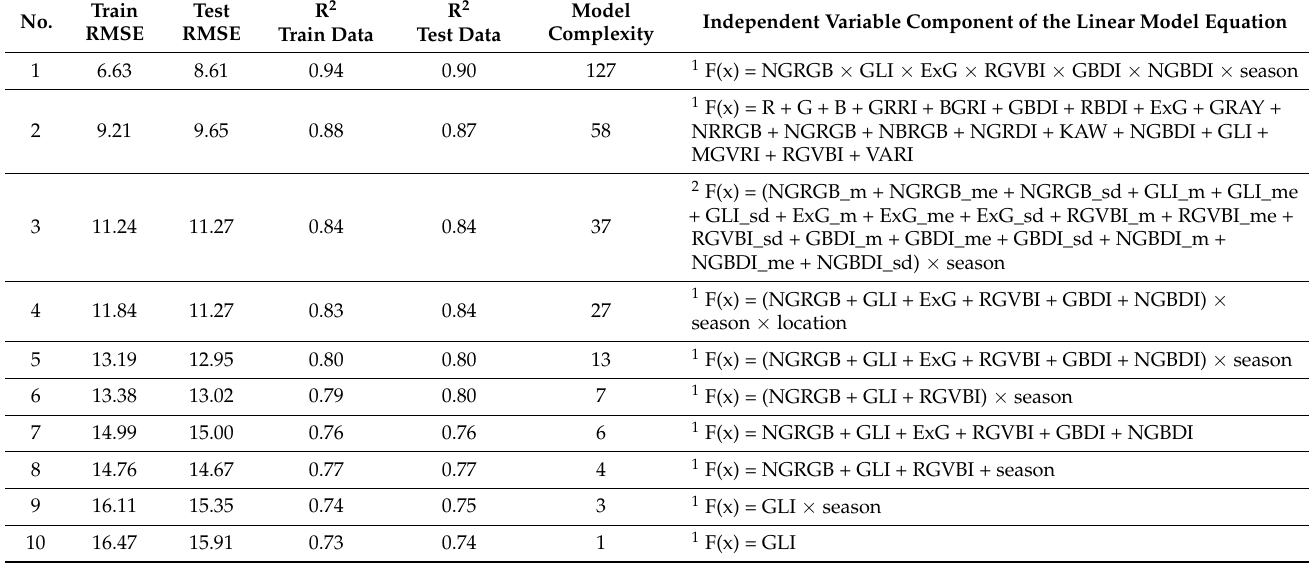
Table 5. The summary of each of the model results. RMSE in both training and test datasets. The model complexity reveals the number of parameters, and the linear model formula is represented as a notation